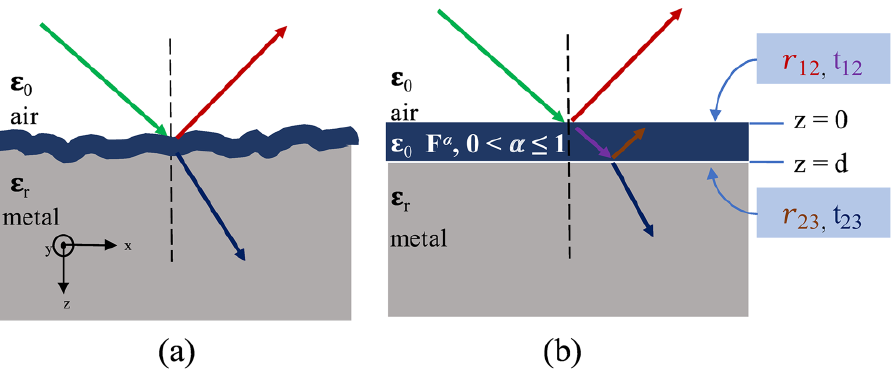
Figure 1. Scheme of laser beam absorption and reflection ( a ) and model for calculating absorption of a rough surface of a metallic material ( b )